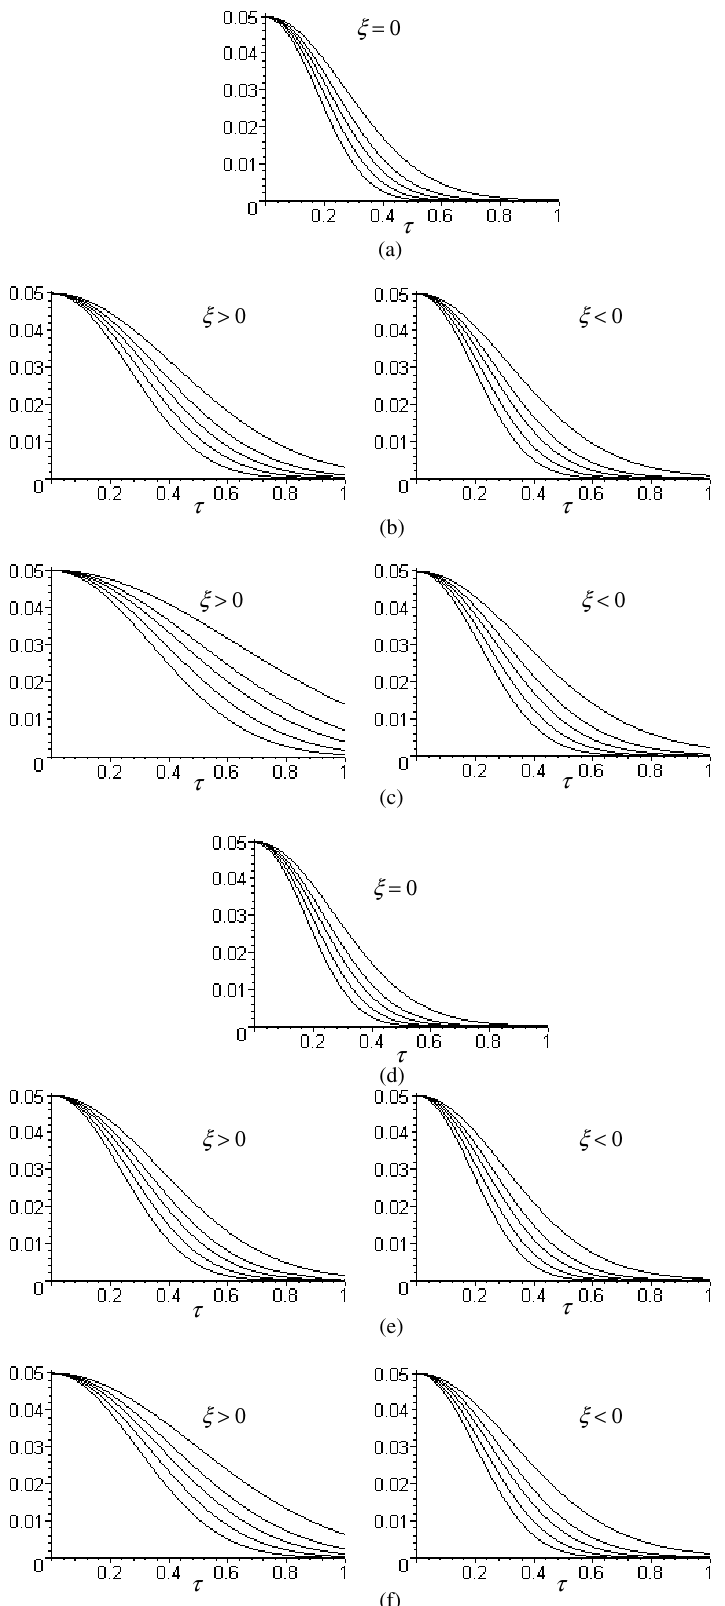
Fig. 1. Plots of α G versus τ with n = 30 , 50 , 70 , 100 , 150 (top to bottom), u = 0 . 5, v = 1 . 5, k = 3, α = 0 . 05 for (a) c = 1, C u c = 1, C u . 5; (c) c = 1, C u c = 1 . 5, C u . 5; (e) c = 1 . 5, C u c = 1 . 5, C u . p = 1; (b) p = 1 p = 2, (d) p = 1 p = 2; (f) p = 2